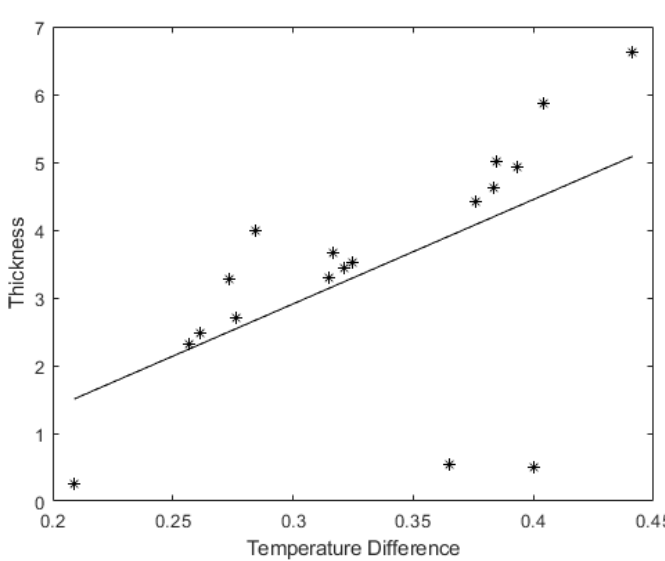
Figure 8. Temperature difference thickness relationship.